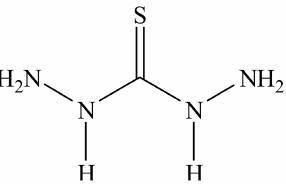
Figure 1. Molecular structure of